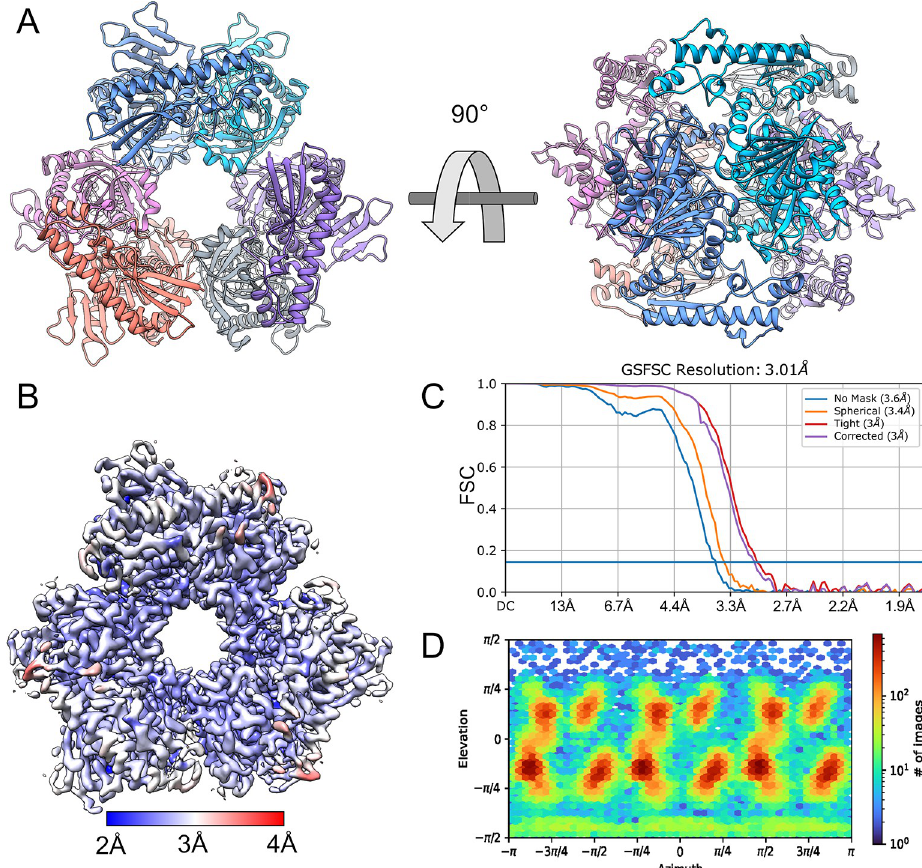
Fig 2. Structure of K . pneumoniae Amn. KpAmn has an overall hexameric structure with D3 symmetry (A, shown colored by chain). The sharpened electron density map (B), colored by local resolution (CryoSPARC at FSC = 0.143 and contoured at 3 σ = 0.604V) reveals the well-defined features of the secondary structure. The resolution of the structure was calculated to be 3.01 Å using the gold standard Fourier shell correlation (GFSC, C). The particles used to generate the final model had a reasonably broad angular distribution